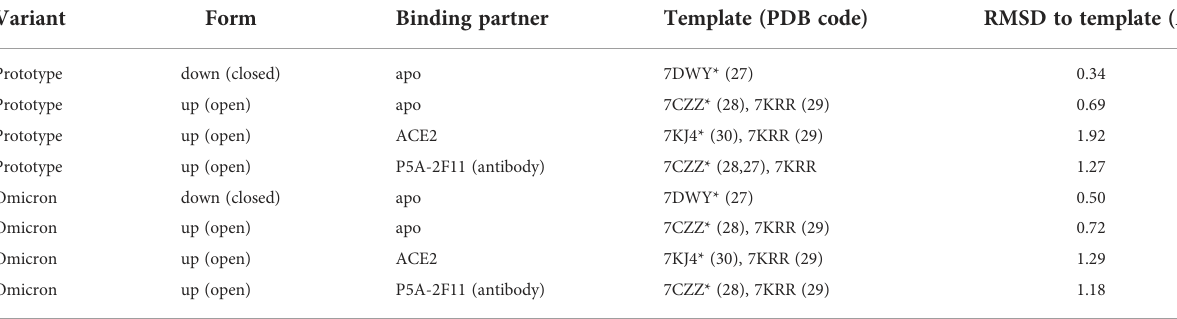
TABLE 2 The templates in homology